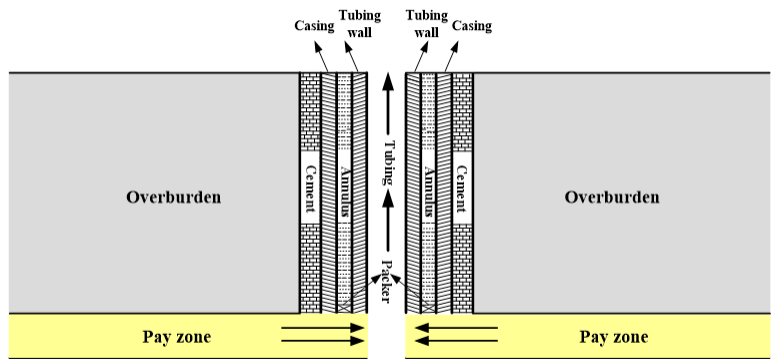
Figure 7. Schematic of downhole configuration for the simplified model.